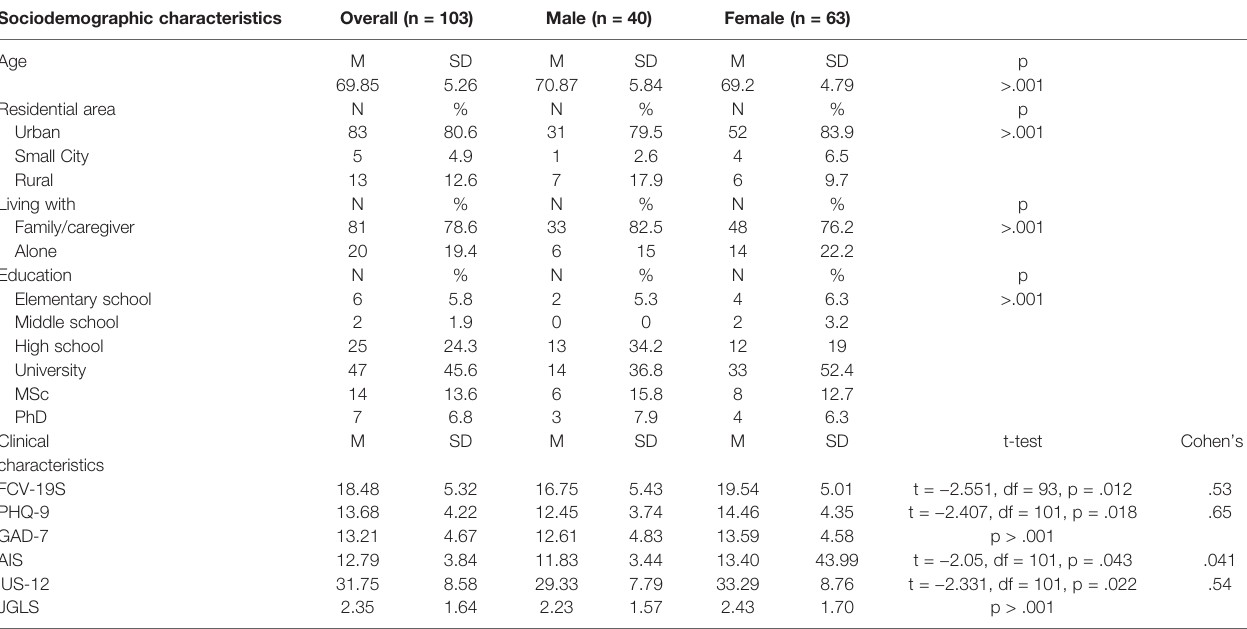
TABLE 1 | Participants ’ sociodemographic and clinical characteristics. Sociodemographic characteristics